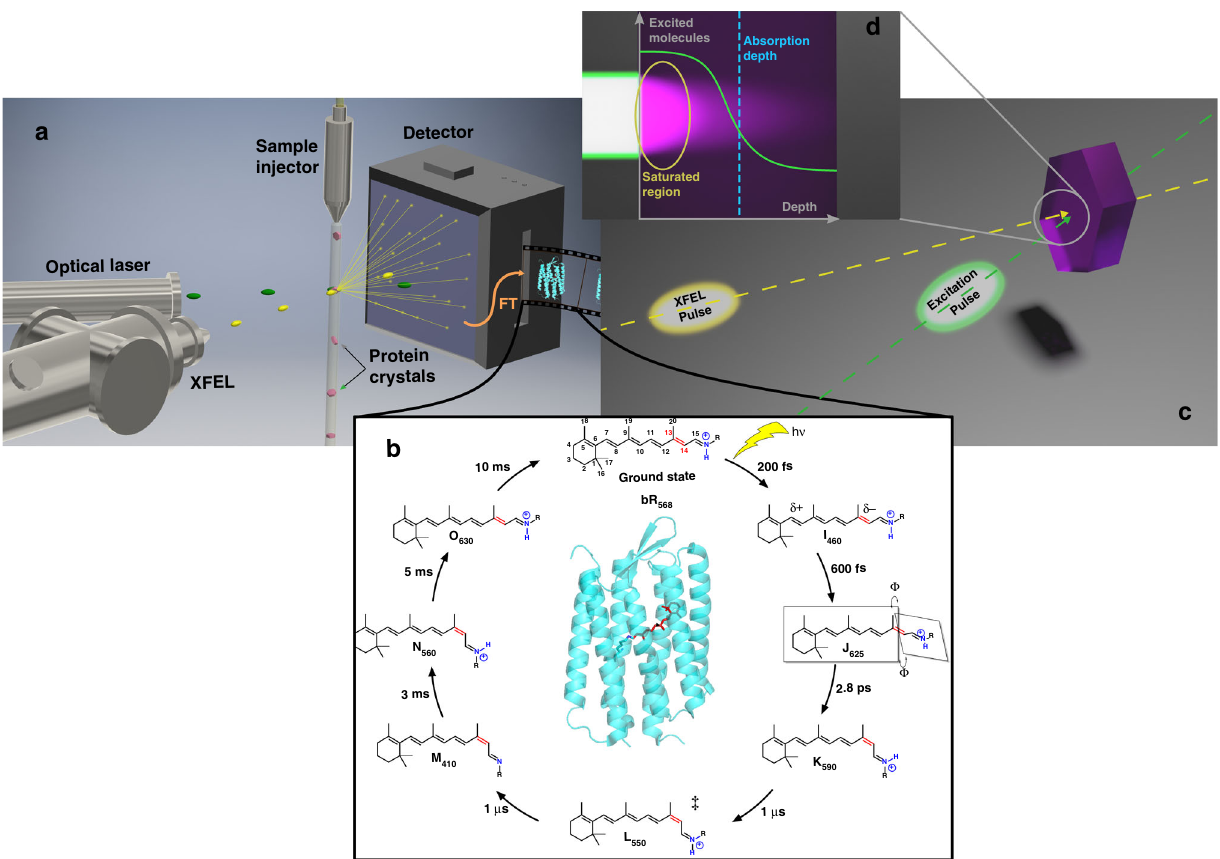
Fig. 1 Making molecular movies and excitation considerations. a Time-resolved serial crystallography is schematically shown using a lipid cubic phase injector per ref. 3 . Femtosecond optical laser pulses (532 nm) initiate the photocycle in a train of bR crystals with random orientations. The fs X-ray (XFEL) pulses capture the photoinduced structural changes by diffraction that are Fourier Transformed (FT) to real space structures to make a movie of the structural changes. b The photocycle of retinal in bacteriorhodopsin (bR) captured in the “ molecular movie ” fi lm in the single photon regime (refer to text for details). Ground state bR (PDB code: 1C3W) is depicted in the center with retinal covalently bound to bR though a Schiff base linkage to a conserved lysine residue. The source of the transported proton is the protonated retinal Schiff base, highlighted in blue. The key isomerization step from all- trans to 13- cis retinal occurs about the C13 = C14 bond, accented in red. ‡ Subsequent, protein structural changes are occurring in the ps – ms time region in order to facilitate proton transport. c The time base for the movies is determined by the speed of light and variable pathlength difference as shown between the fs excitation and fs X-ray probe pulses to give <100 fs time resolution to atomic motions. d The inset shows the mismatch between the laser excitation, which is strongly absorbed, and the X-ray pulse, which samples the entire crystal thickness (10 µ m scale). Excitation well above 1-photon per photoactive chromophore is often used to try to excite a larger fraction of the probed volume to decrease unexcited background scatter from obscuring the photoinduced structural changes. At such high fl uences, saturation effects occur (shown) that also lead to fully resonant coherent 2-photon, sequential resonant 2-photon, nonresonant 2-photon, to n-photon transitions depending on the laser pulse width and associated peak power. Crystals on the order of the 1/ e absorption depth (dashed blue line) should be used for maximum contrast above background under conditions to ensure 1-photon absorption to well de fi ned excited states (see